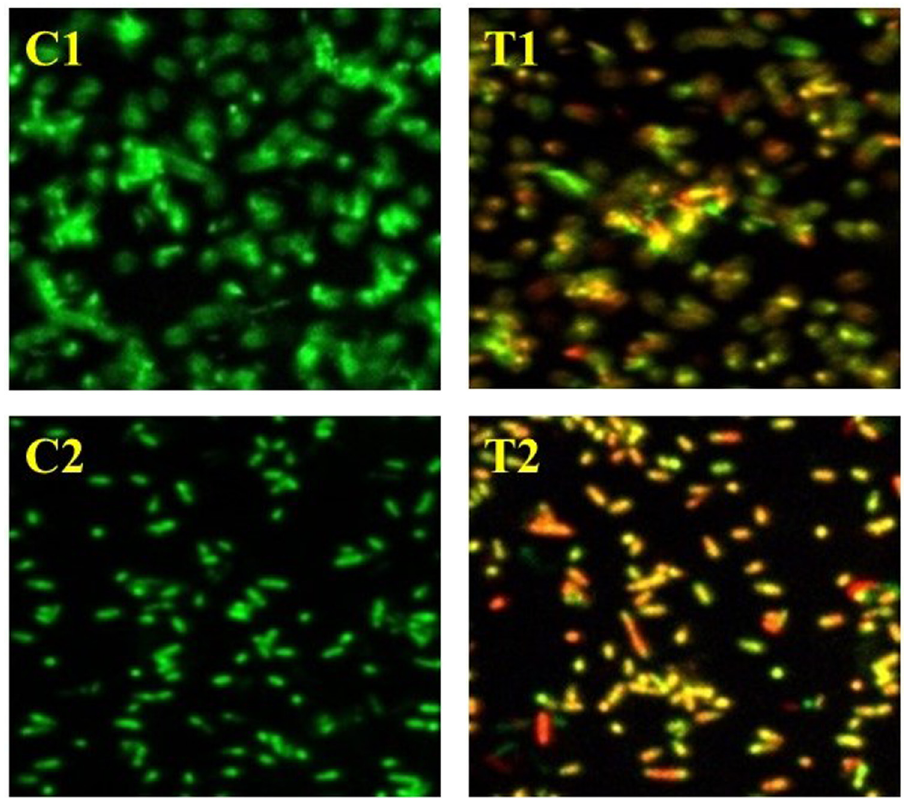
Figure 3: LIVE/DEAD fl uorescent double staining ( SYTO9 and PI ) . Green color: live cells that have intact cell membrane, yellow and red color: bacterial cells that have damaged cell membrane or dead cells or necrotic cells. C1: Gram - positive control bacterial cells, T1: Gram - positive bacterial cells nanoemulsion treated, C2: Gram - negative bacterial cells control, T2: Gram - negative bacterial cells nanoemulsion